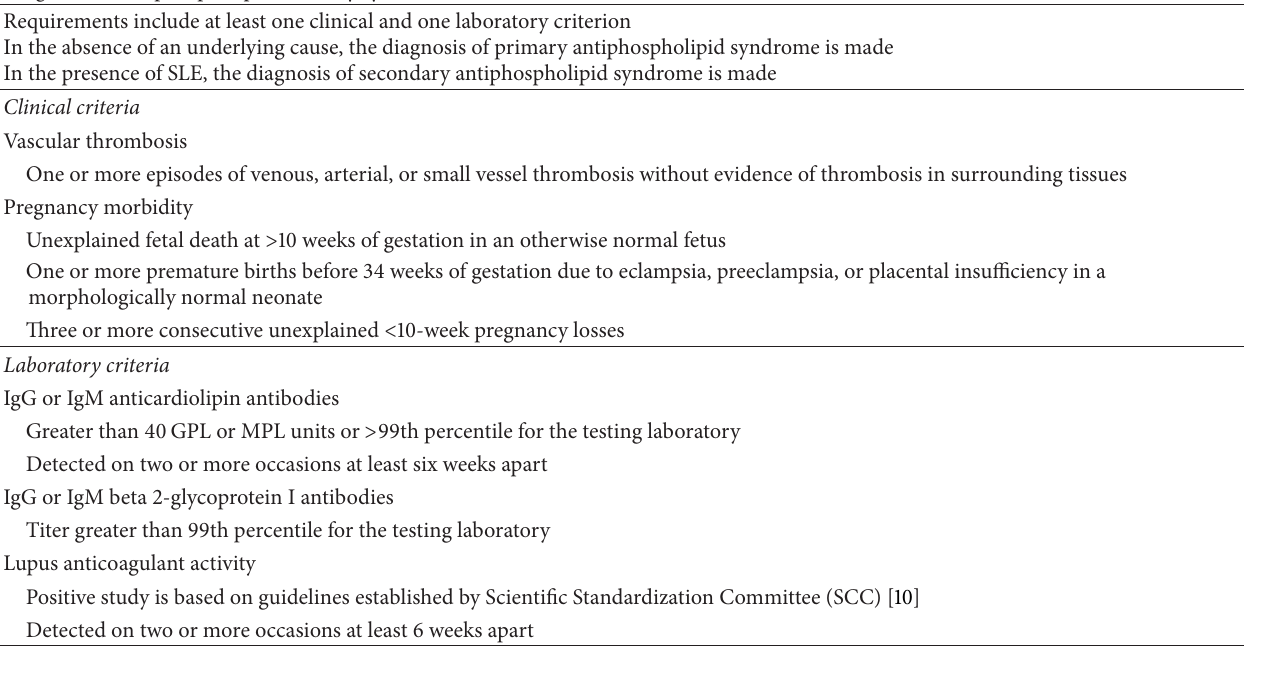
Table 3: Diagnostic criteria for diagnosis of catastrophic antiphospholipid syndrome as defined by International Congress on Antiphospho- lipid Antibodies Task